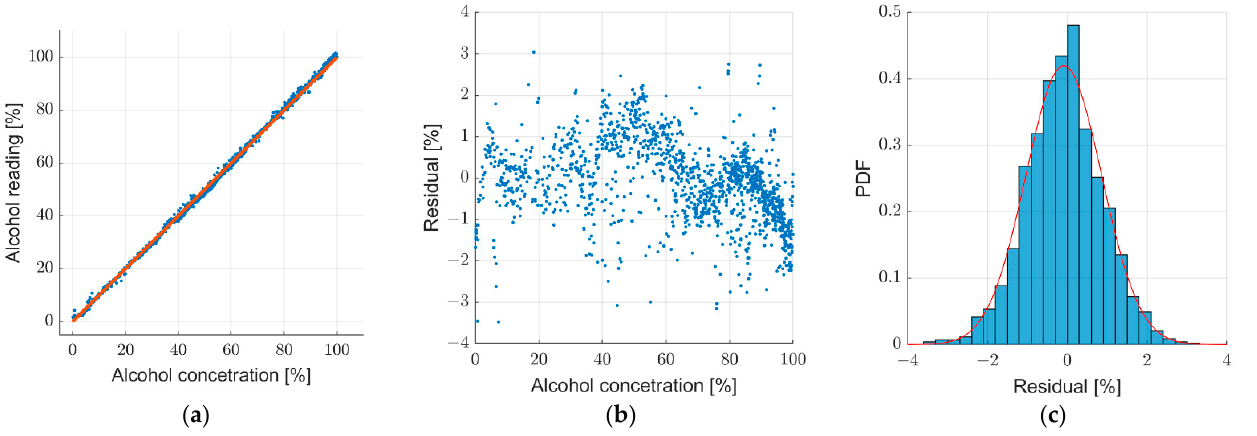
Figure 11. Regression model prediction on test dataset results: ( a ) scatter plot of alcohol reading versus alcohol concentration label (blue dots) and ideal sensor characteristic (red line); ( b ) scatter plot of residuals with respect to alcohol concentration labels; ( c ) normalized histogram of residuals (blue bins) and fit of Gaussian probability density function (red curve).